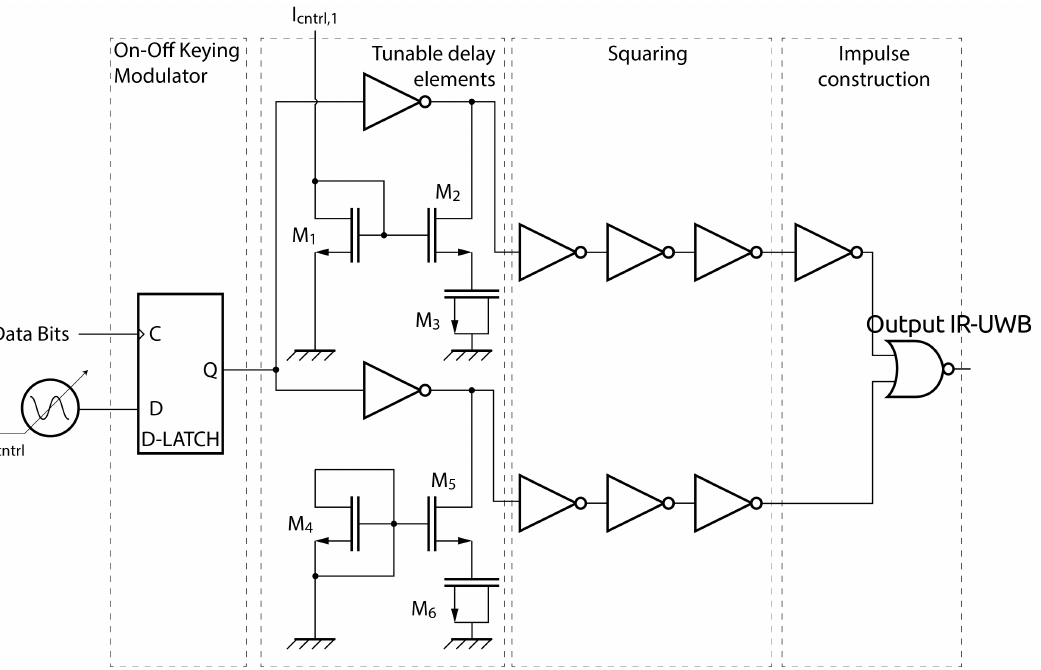
Figure 2. Schematic of the IR-UWB transmitter. Note that the presented and measured IC does not include the filter nor the